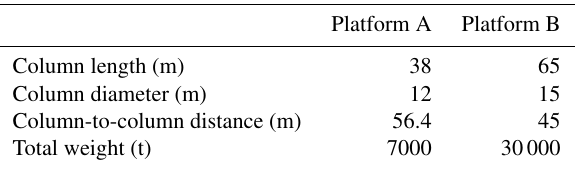
Table 2. Basic characteristics of the two reference